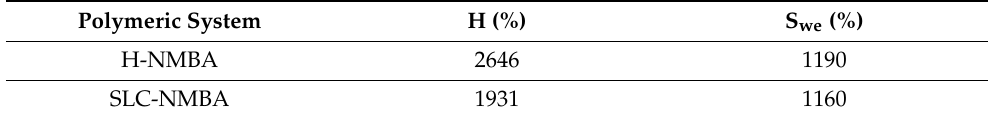
Table 8. Swelling Percentages obtained in T-1